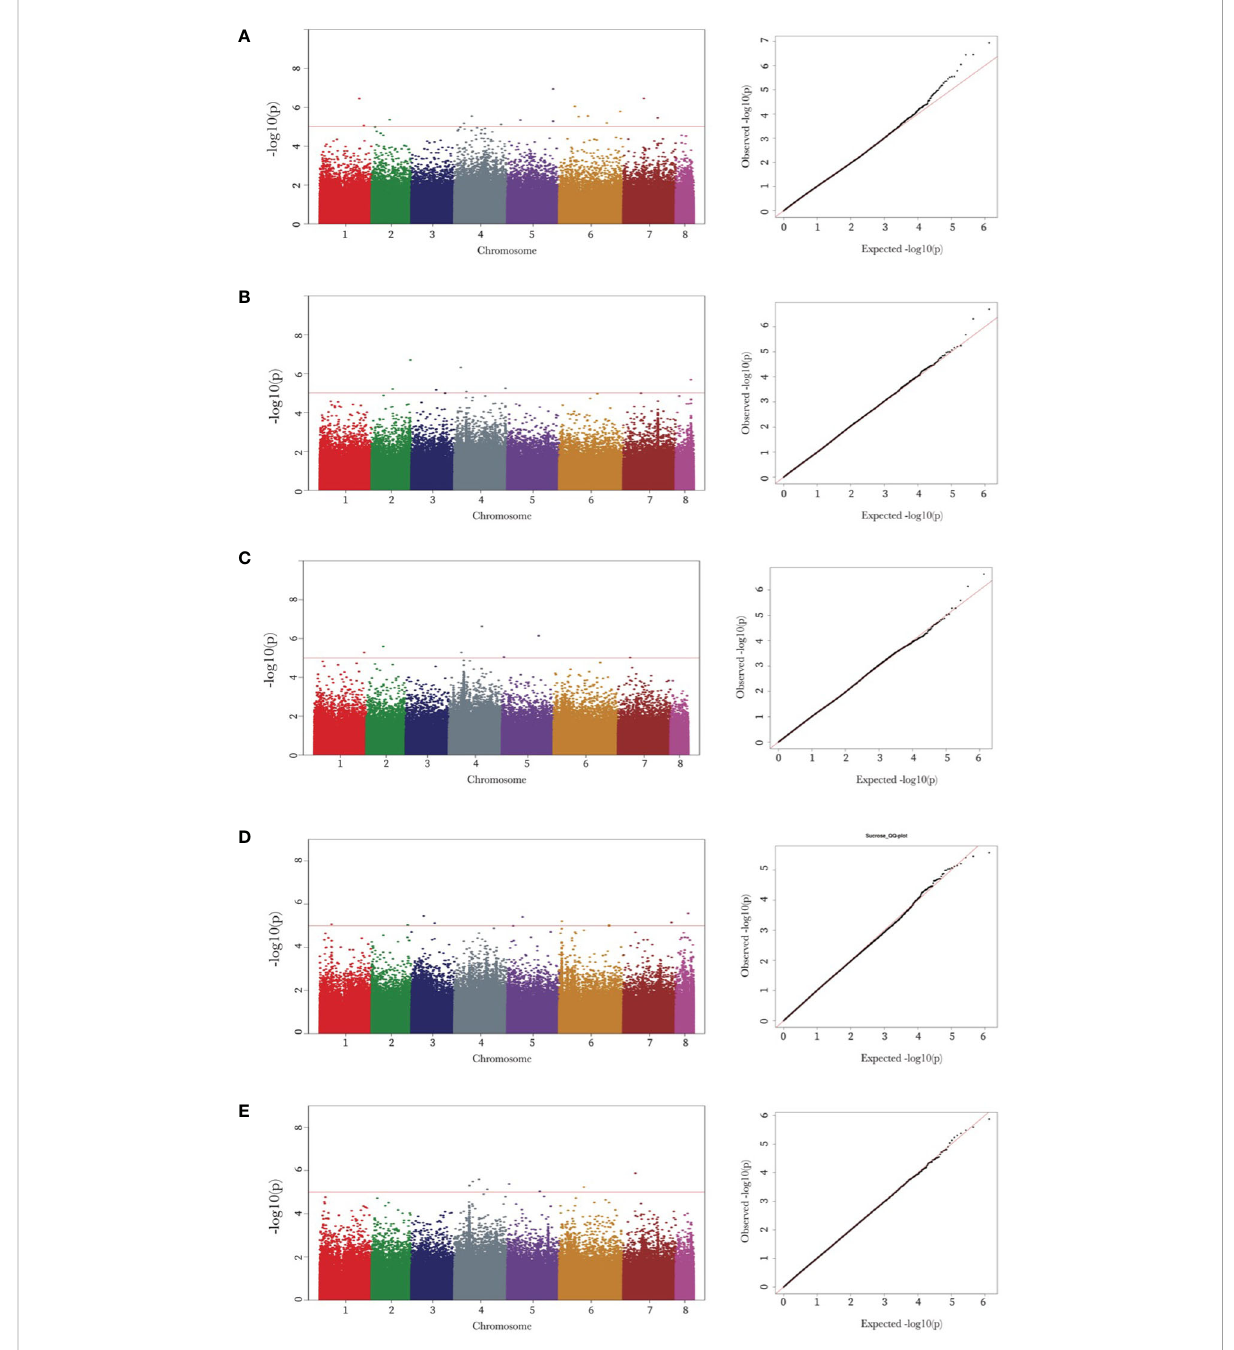
FIGURE 3 Manhattan and quantile-quantile (Q-Q) plots of raf fi nose, stachyose, ciceritol, sucrose, and total sugars in chickpea. Manhattan and Q-Q plots of the seed oligosaccharides from a to e are as follows: raf fi nose (A) , stachyose (B) , ciceritol (C) , sucrose (D) , and total sugars (E) . Negative log 10 transformed P values (y-axis) are plotted against the physical single nucleotide polymorphism (SNP) position on each chromosome (x-axis). Each circle represents a SNP, and the corresponding SNPs were mentioned trait wise. The dotted red line represents the genome-wide signi fi cance threshold as determined by Bonferroni correction at.05. Regions with negative log 10 P values above the threshold contain quantitative trait loci